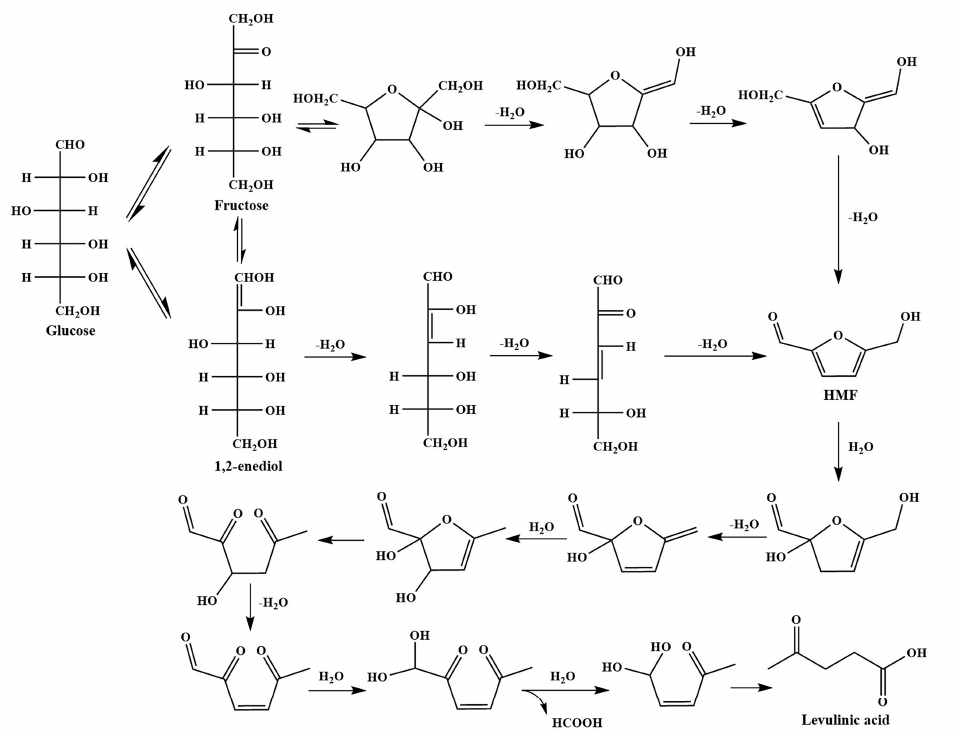
Figure 2. Possible reaction mechanism for the formation of LA. Reproduced from Ref. [30]